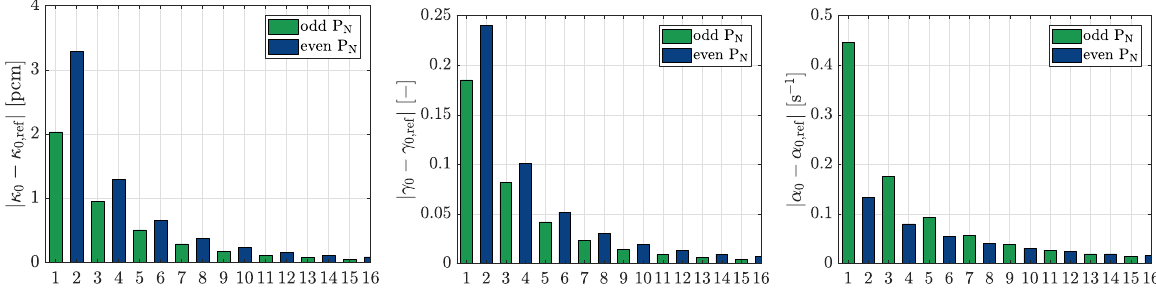
Figure 1: κ , γ , and α eigenvalues convergence as a function of the angular approximation order with Mark BCs using the roots of L N